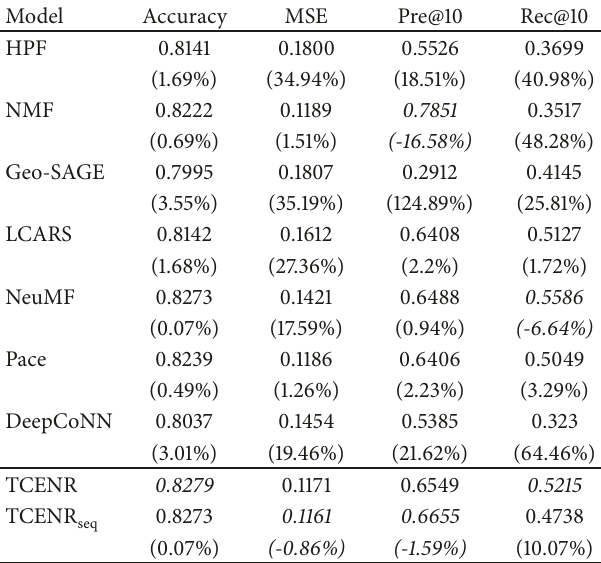
Table 1: Performance comparison over the Yelp dataset. Improve- ment of TCENR compared to each method is shown in